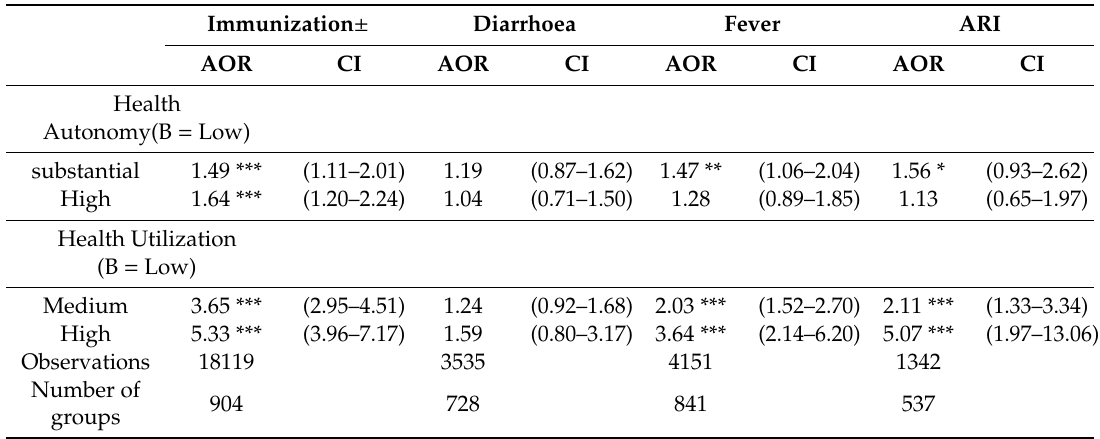
Table A2. Adjusted odds ratio of robustness check from multilevel logistic regression on preventive and curative infant and child health in Nigeria (2008–2013).